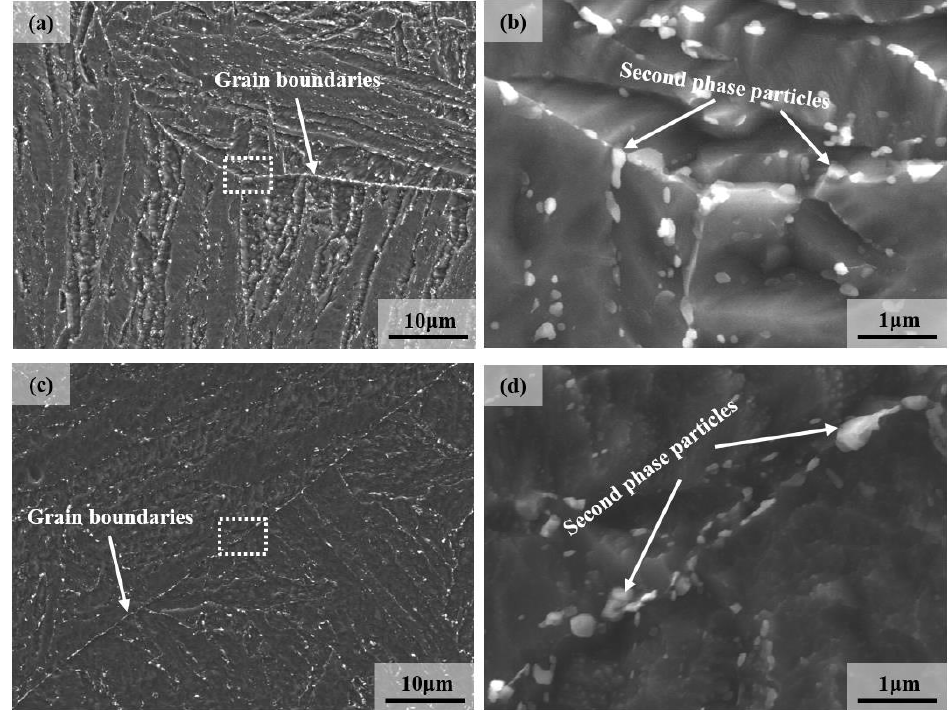
Figure 8. Scanning electron microscope (SEM) image of heat-resistant steel after heat treatment: ( a ) and ( b ) 9Cr–1.5Mo–1Co, ( c ) and ( d ) 9Cr–3W–3Co.